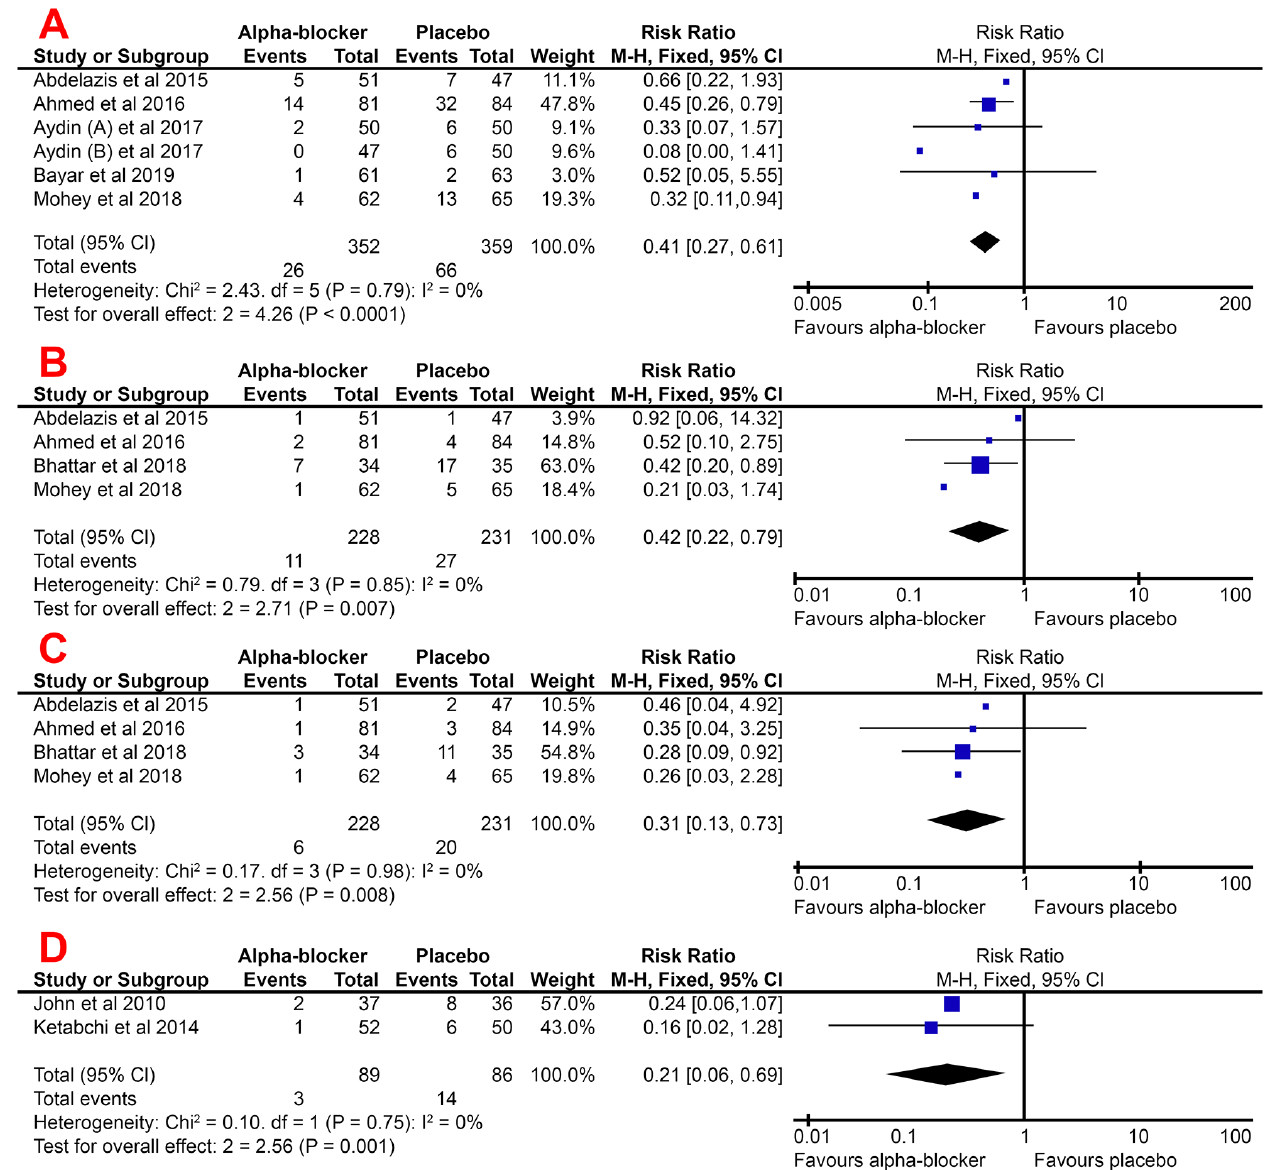
Figure 4. Forest plot of overall complication rate ( A ), hematuria ( B ), mucosal injury ( C ), and colic episode ( D ) pooled RR for the group treated with alpha-blocker compared to control group.